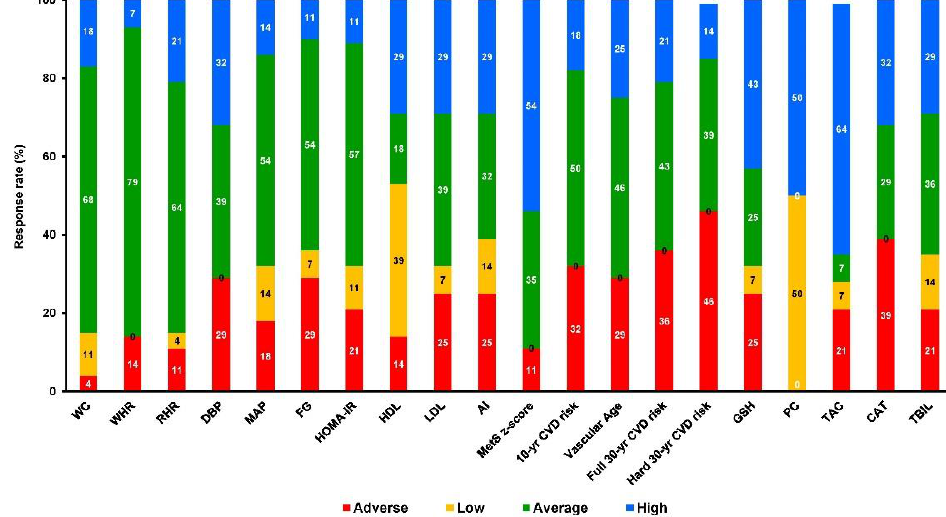
Figure 4. Multiple differential responder groups to exercise in TR following a 5-month intervention.